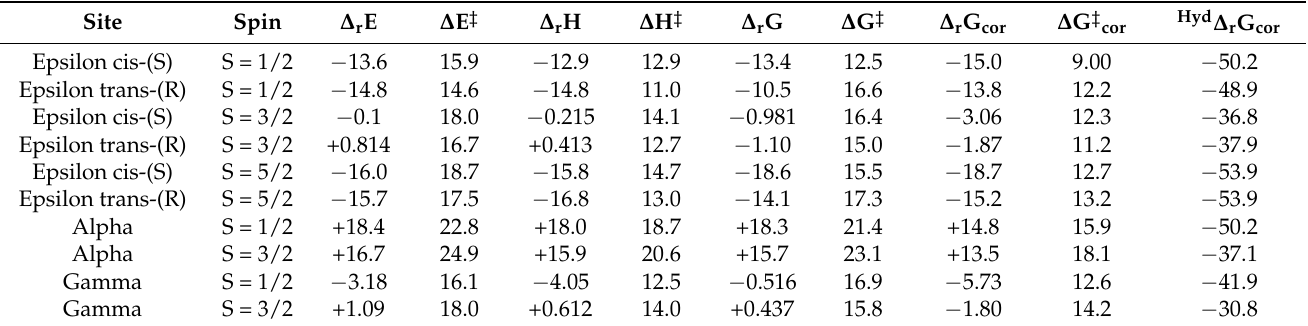
Table 7. Thermodynamic and kinetic data computed for the hydrogen capture reaction by CYP in α -pinene. The terms ∆ r E, ∆ r H, and ∆ r G refer to electronic, enthalpic, and Gibbs free energy variation in the reaction, respectively. The terms ∆ E ‡ , ∆ H ‡ , and ∆ G ‡ refer to the electronic, enthalpic, and Gibbs free energy reaction barriers, respectively, and the term “cor” refers to the dispersion, BSSE, and Grimme quasi-harmonic corrections to the calculated absolute Gibbs free energies. Hyd ∆ r G cor refers to the hydroxylation free energies computed as the difference between the hydroxylated product and the reactant in coordinate 1. Data are displayed in kcal/mol.